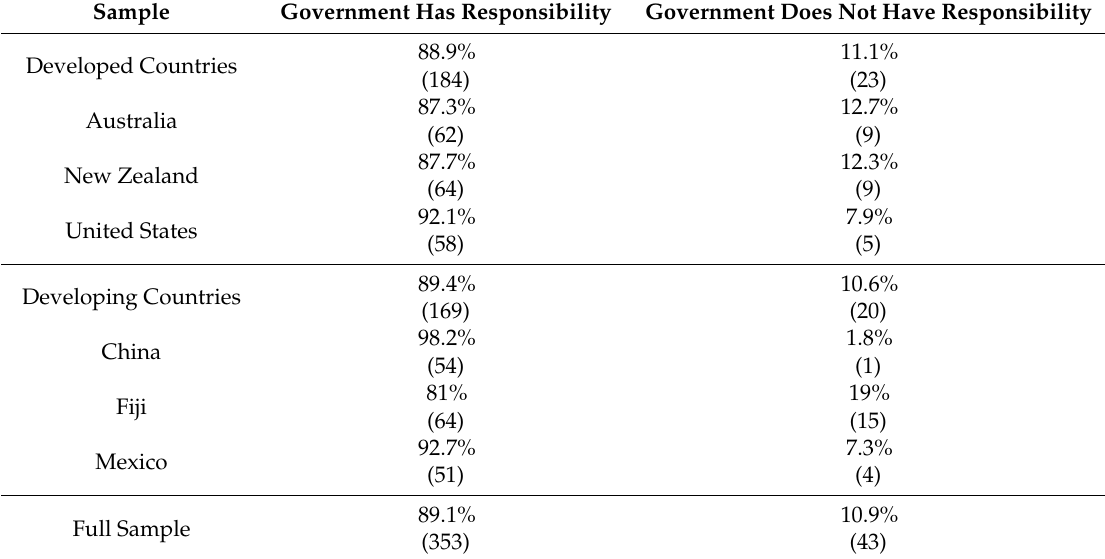
Table 9. Frequency of government responsibility.